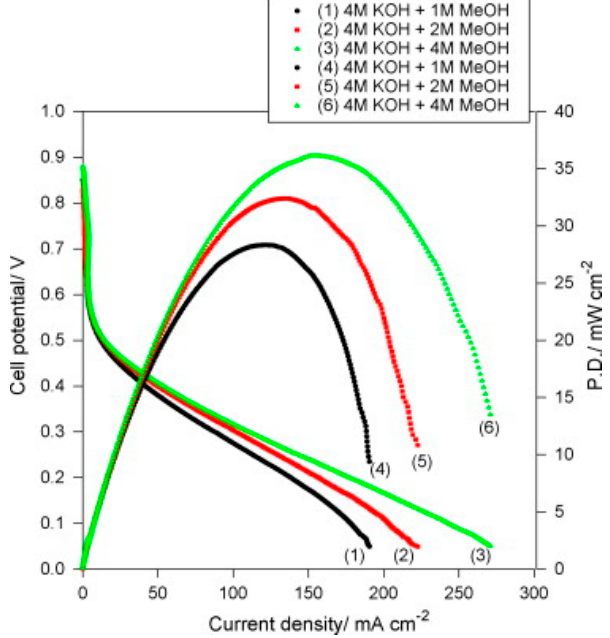
Figure 12. DMFC curves of QPVA/10 wt% Al 2 O 3 composite membrane with various fuels (4 M KOH + x M CH 3 OH) at 25 °C and in ambient air. Reproduced with permission from Ref. [111].